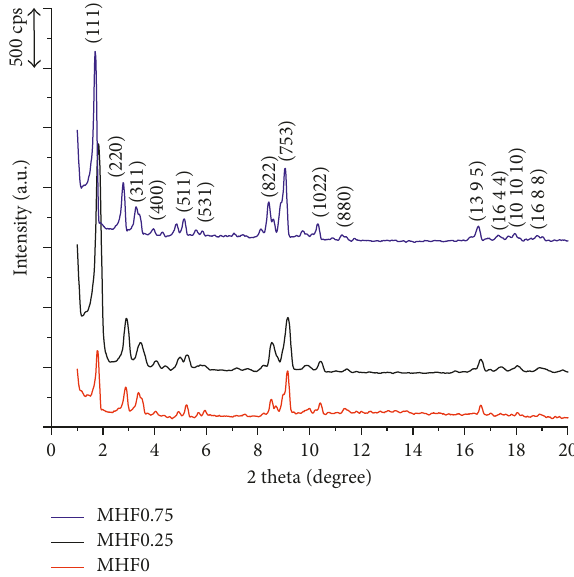
Figure 1: XRD patterns of MIL-101 synthesized with different molar ratios of HF/H 2